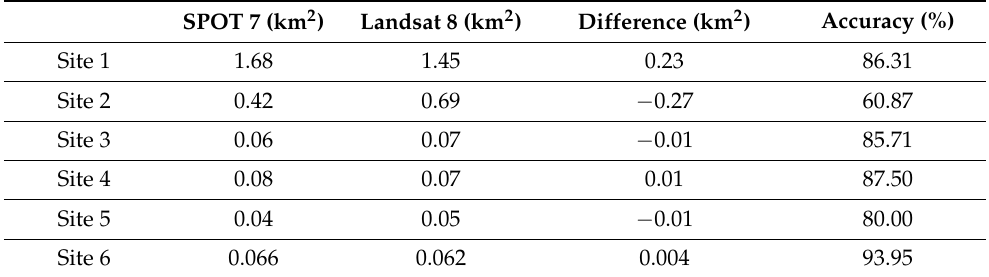
Figure 10. Comparison of images derived from Landsat 8 and SPOT 7 showing debris-covered ice and clean ice outlines at various spots. The black line shows outlines derived from SPOT 7 and the red line shows outlines derived from Landsat 8. S7: SPOT 7, L8: Landsat 8, Overlay: S7 + L8. Table 2. Comparison between debris-covered ice and clean ice boundaries obtained from SPOT 7 and Landsat